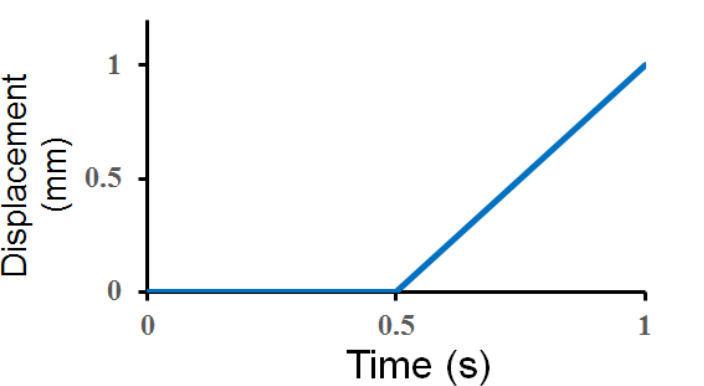
Figure 3. Magnitude of load conditions used in this study. Amount of displacement applied to the vacuum extractor.